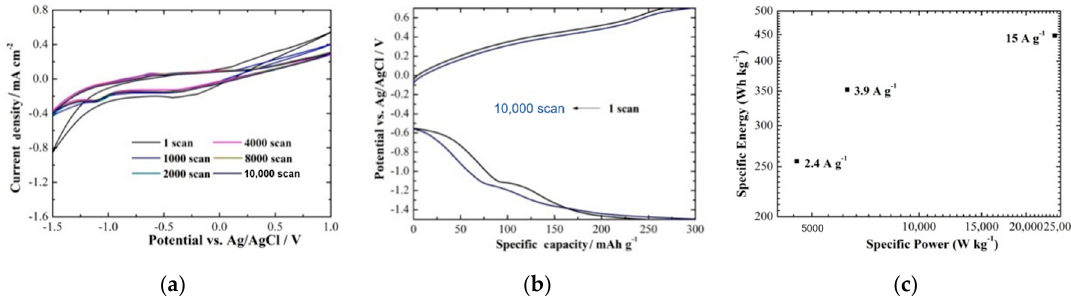
Figure 7. ( a ) Current–potential curves of the V 2 O 5 coatings grown by AACVD at 600 °C sweeping the potential between − 1.5 V and + 1.0 V in 0.075 M MgCl 2 for 1, 1000, 2000, 4000, 8000, and 10,000 scans. ( b ) Specific capacity of the cathodes for a potential ranging − 1.5 V to + 0.7 V for 1 and 10,000 scans. ( c ) Ragone plot for a specific current of 2.4, 3.9, and 15 A g − 1 .